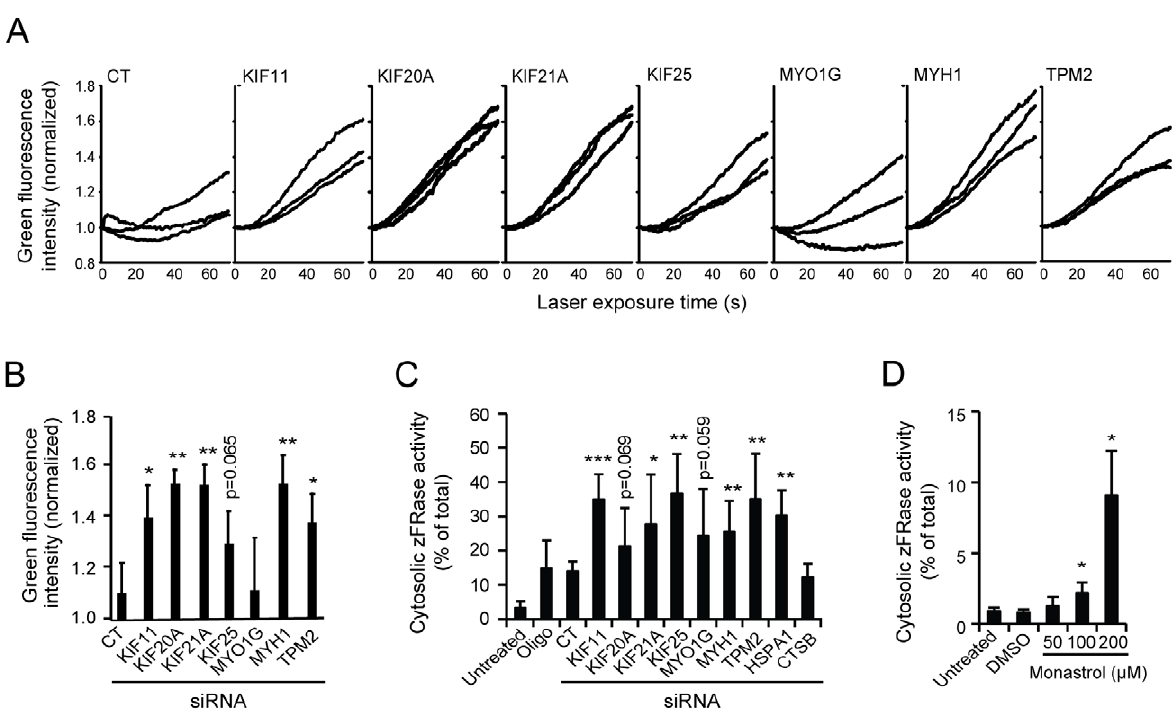
Figure 4. Reduction of lysosomal stability by the identified siRNAs and monastrol. (A–C) MCF7 cells were left untreated, treated with Oligofectamine (Oligo) or transfected with control siRNA (CT) or indicated siRNA pools (3 6 6.67 nM). (A and B) After 60 h, cells were treated with acridine orange and analyzed by live cell imaging to measure the loss of lysosomal integrity (increased green fluorescence) upon laser treatment. A miminum of 25 cells from pre-defined areas was examined for each experiment. Three independent experiments are shown in A and values in B represent means + SD of these experiments at the 60 sec time point. (C) After 72 h, cytosolic and total cysteine cathepsin activities were measured by analyzing the cleavage of zFR-AFC. The activities in cytosolic extracts are shown as percentages of the activities in the corresponding total extracts. HSPA1 and CTSB siRNAs served as controls for the induction of lysosomal leakage and transfection efficacy, respectively. (D) Cytosolic cysteine cathepsin activities in MCF7 cells left untreated or treated with vehicle (2% dimethyl sulfoxide, DMSO) or indicated concentrations of monastrol for 72 h were determined as in (C). Values represent means + SD of five (C) or three (D) independent experiments. * P , 0.05, ** P , 0.01, *** P , 0.001, vs. control siRNA-transfected (B, C) or vehicle-treated cells